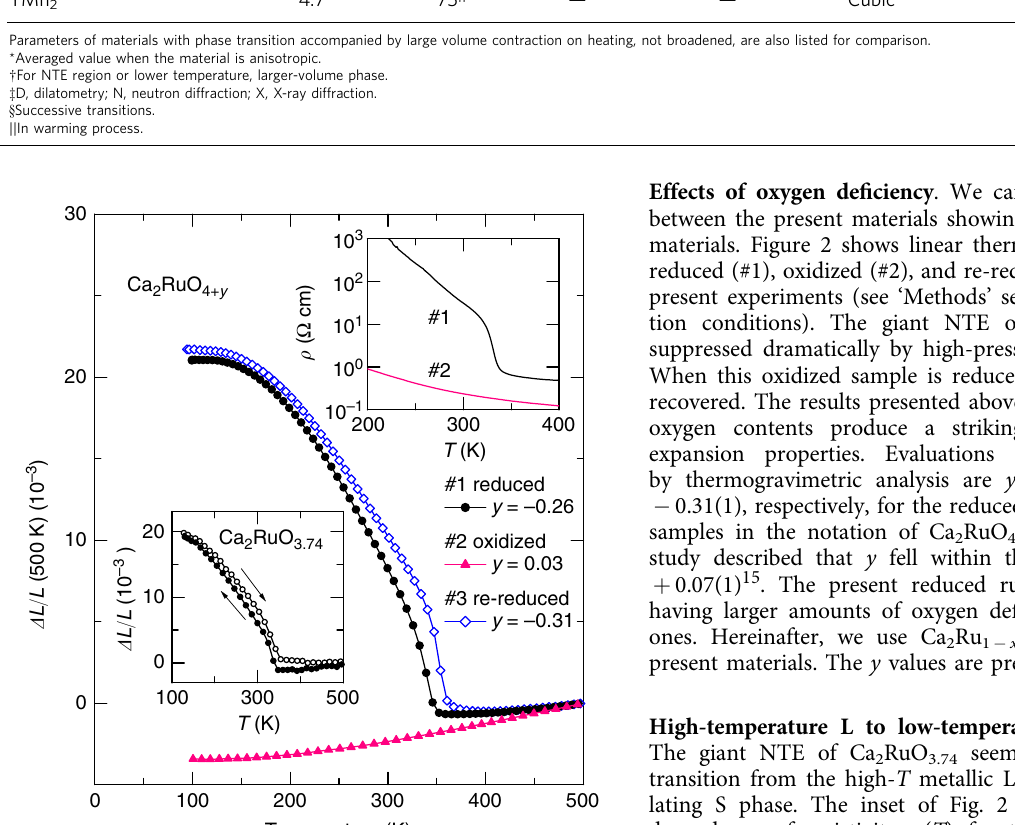
Figure 2 | Linear thermal expansion D L/L of Ca 2 RuO 4 þ y . The data were collected on a warming process using a laser-interference dilatometer. Reference temperature: 500K. The hysteresis loop was observed in D L/L measurements using a thermomechanical analyzer for #1 (inset). The giant negative thermal expansion (NTE) of #1 is suppressed by the oxidizing procedure, but is fully recovered by the re-reducing procedure. Inset shows temperature dependence of resistivity r ( T ) for #1 and #2. The abrupt jump in r ( T ) at 345K for #1 corresponds to the Mott metal-to-insulator transition, which coincides with the onset of